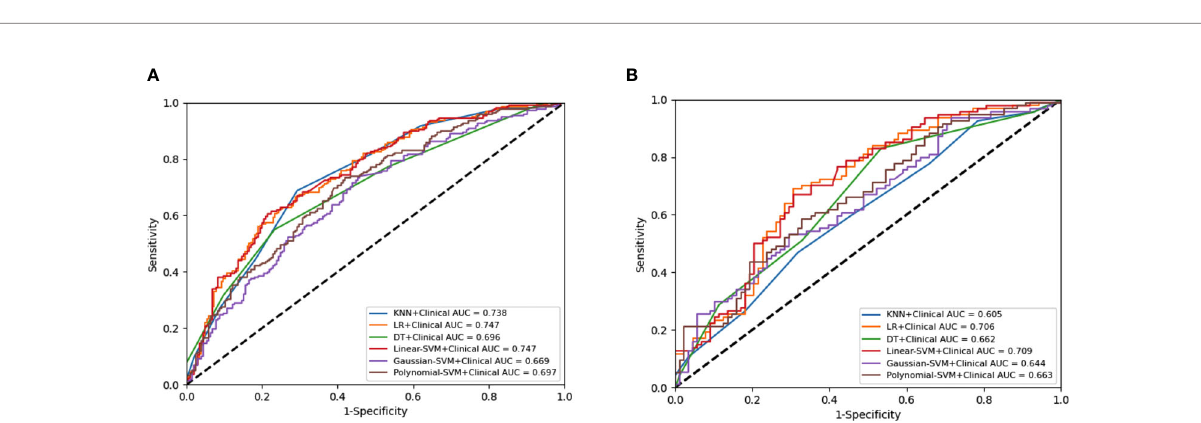
FIGURE 5 | Receiver operating characteristic (ROC) curves of the combined model constructed by six algorithms in the training set (A) and internal test set (B) .